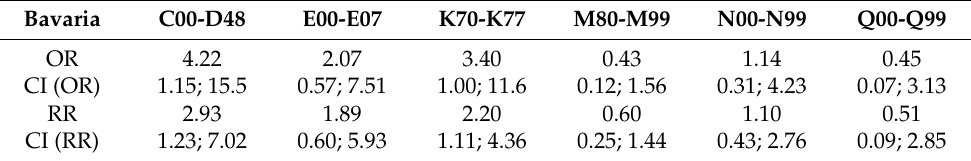
Table 5. Odds ratio (OR) and relative risk (RR) calculations using maximum drinking water U concentration >10 µ g/L as risk factor. 95% CI: 95% confidence intervals (lower and upper limit). Bavaria C00-D48 E00-E07 K70-K77 M80-M99 N00-N99 Q00-Q99